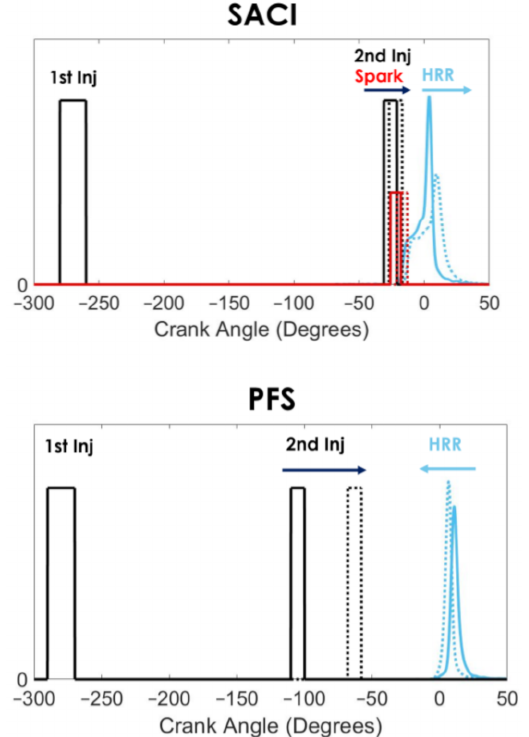
Figure 7. Fuel injection and spark strategies used for SACI combustion ( top ) and PFS combustion ( bottom ). For SACI combustion, combustion phasing is delayed with retarded fuel injection timing. For PFS combustion, combustion phasing is advanced with retarded fuel injection